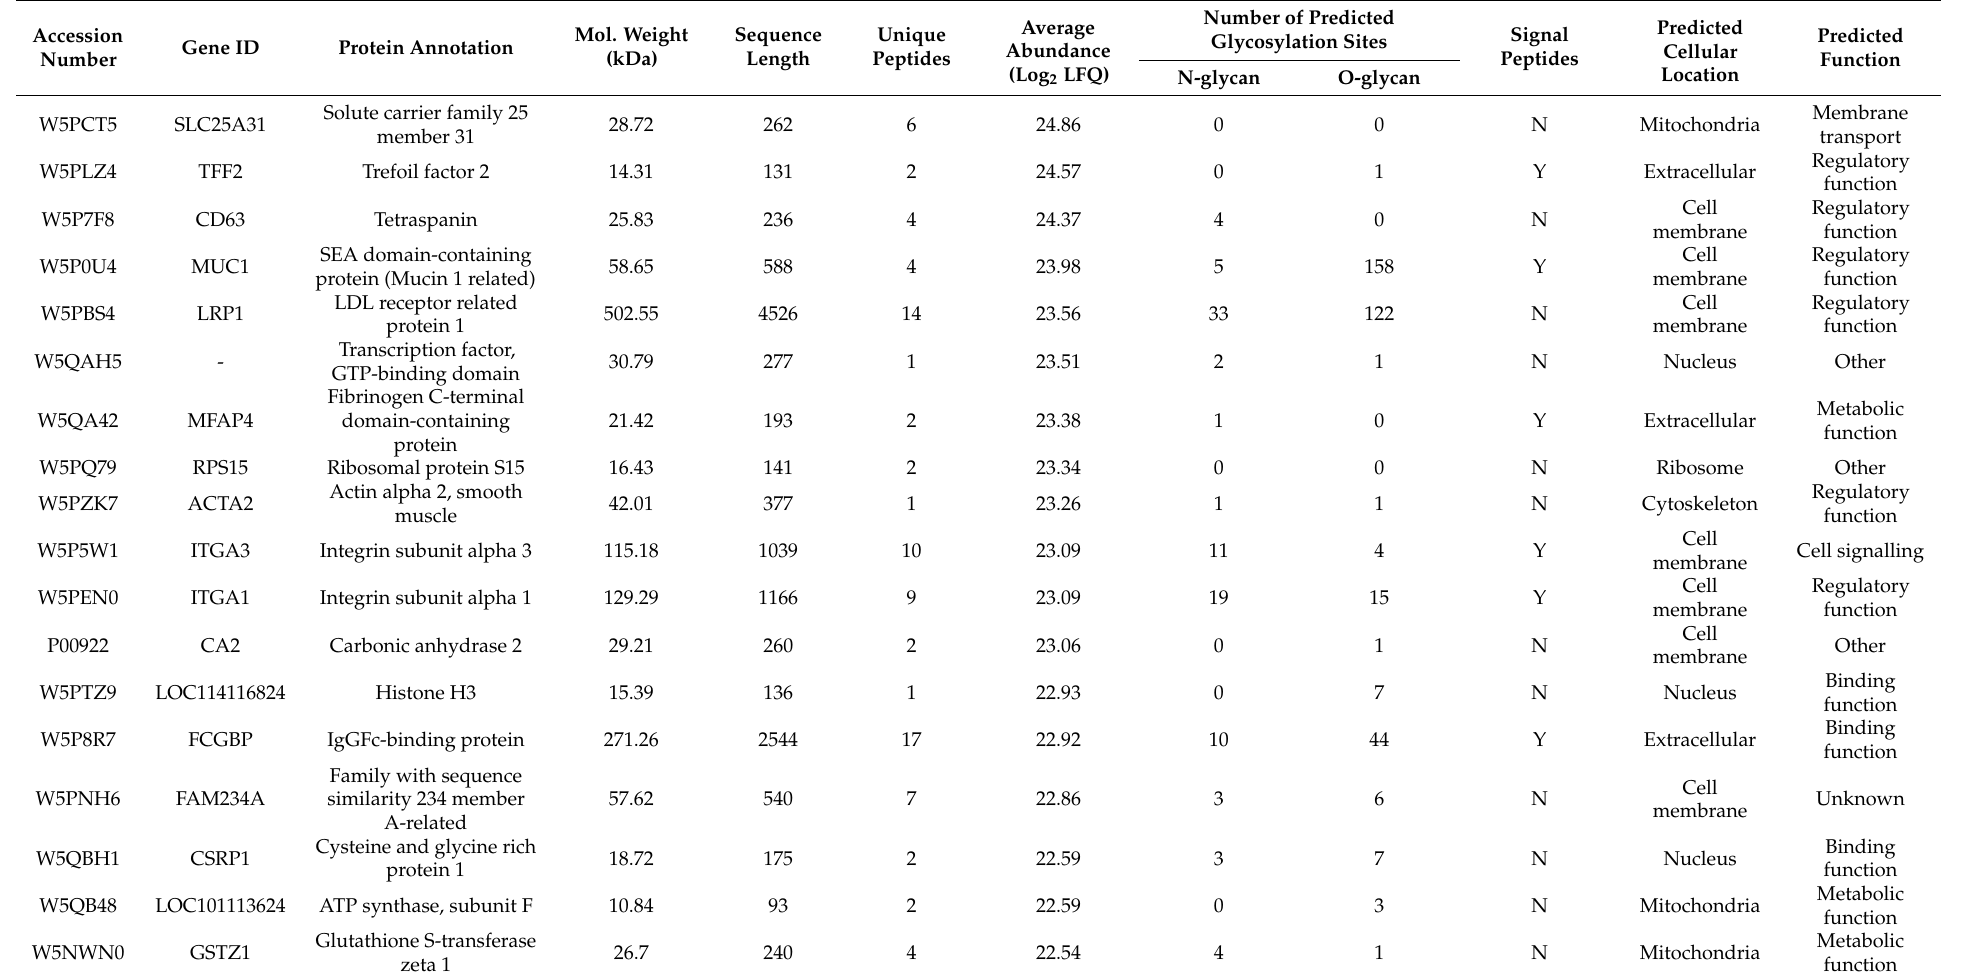
Table 1. Identification by mass spectroscopy of top 50 most abundant sheep abomasal whole tissue (WT) proteins eluted from a Tci-gal-1